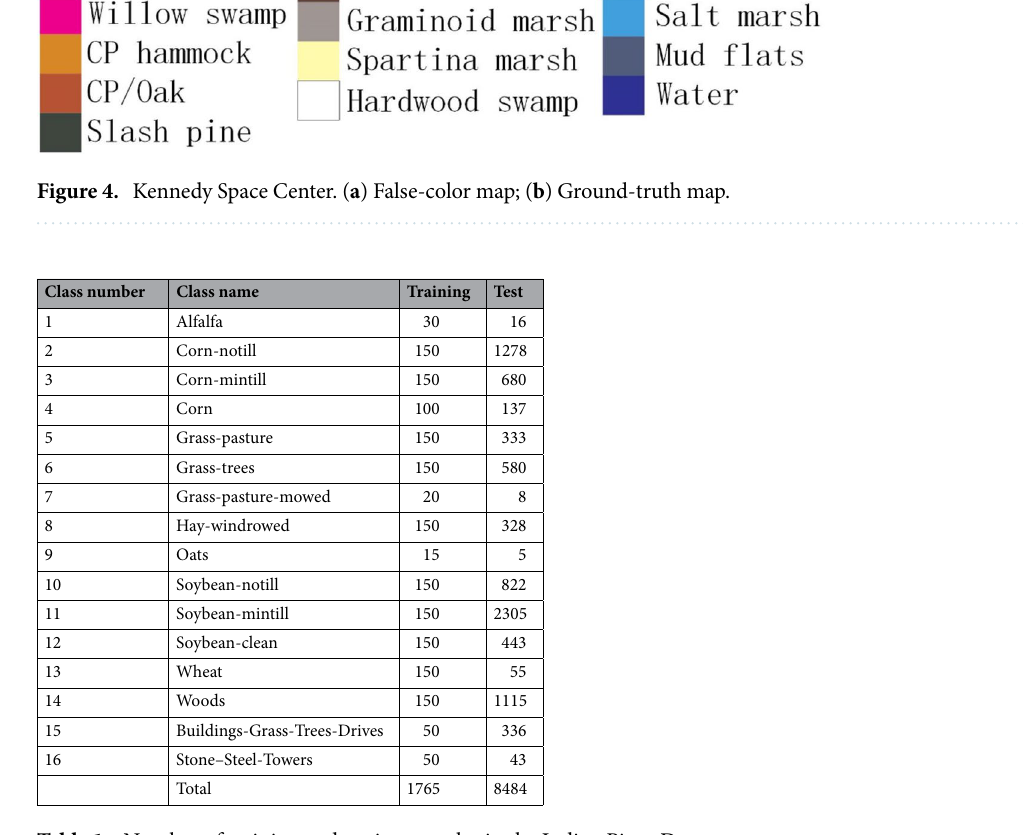
Table 1. Number of training and testing samples in the Indian Pines